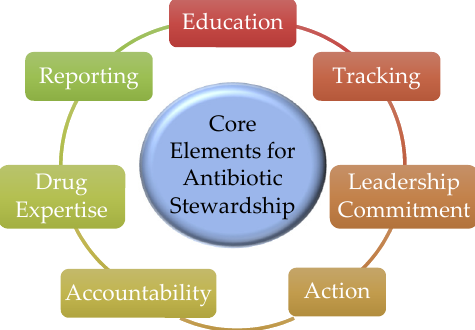
Figure 6. The core elements for antibiotic stewardship programs. Antibiotics and the Need for TDM and Dosage